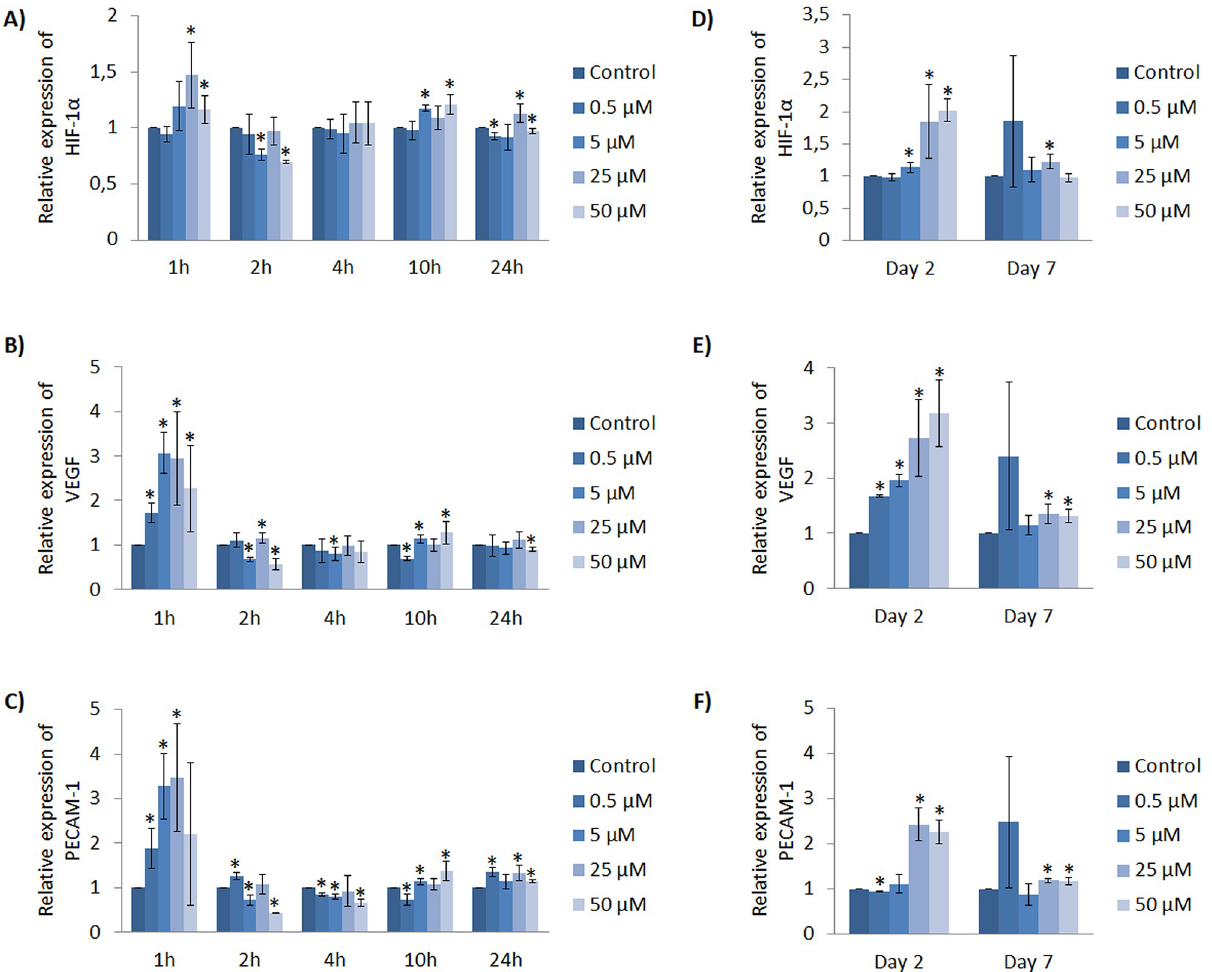
Fig 4. HUVEC gene expression profile cultured with Co 2+ within short (hours) and longer (days) time points. Different Co 2+ concentrations were evaluated at 1, 2, 4, 10 and 24h for the gene expression of (A) HIF-1 α , (B) VEGF and (C) PECAM-1. Different Co 2+ concentrations were also evaluated at 2 and 7 days for the expression of (D) HIF-1 α , (E) VEGF and (F) PECAM-1. Data represented correspond to fold-changes compared to each time point control. Statistically significant differences were represented with � (p <